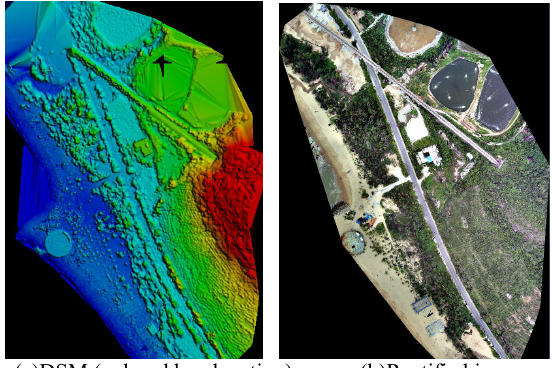
Figure 6. DSM and rectified image produced by mode